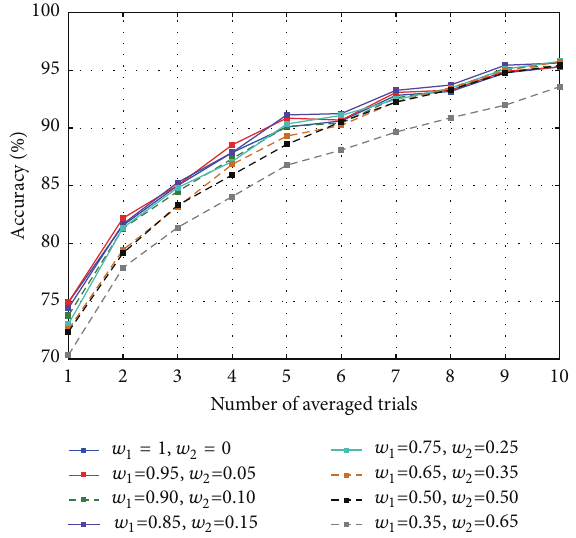
Figure 3: Average classification accuracy of 12 subjects as a function of the number of averaged samples for each